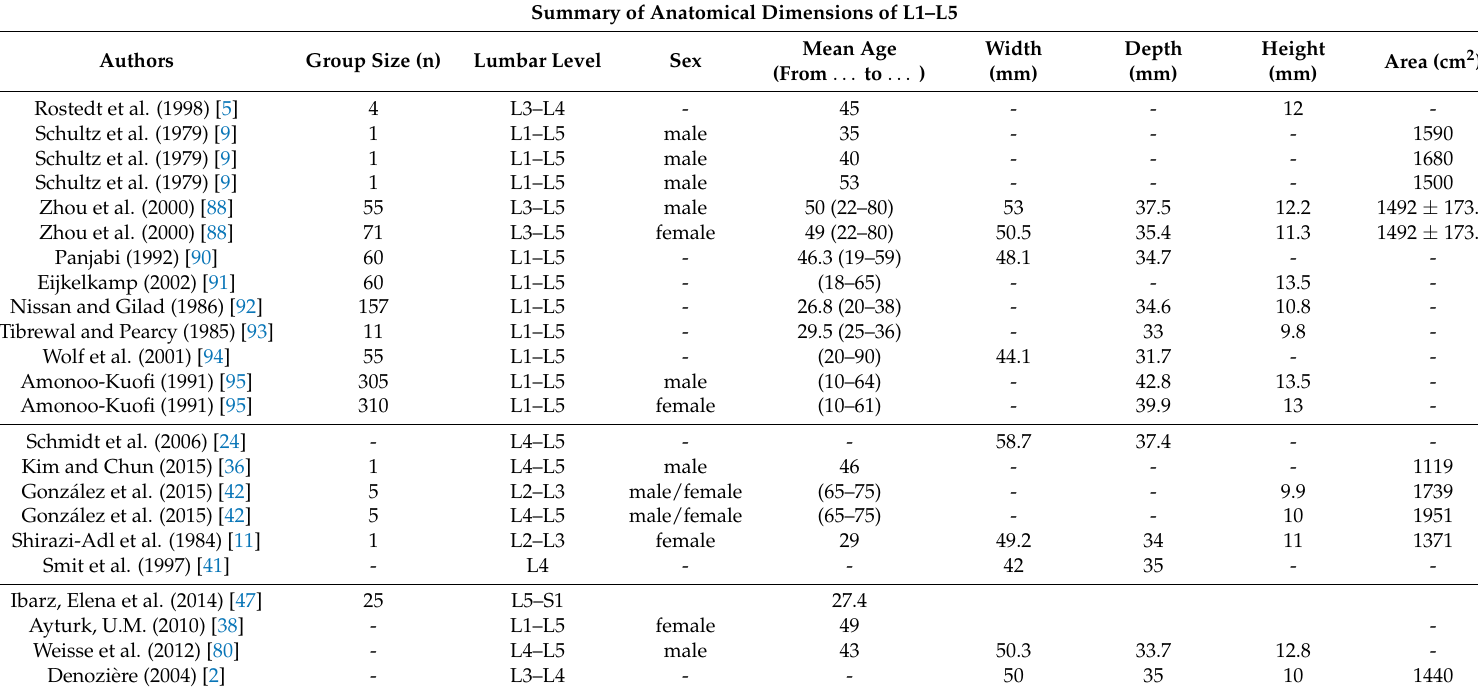
Table 8. Range of the material parameters proposed to define the behavior of human intervertebral lumbar disc models based on